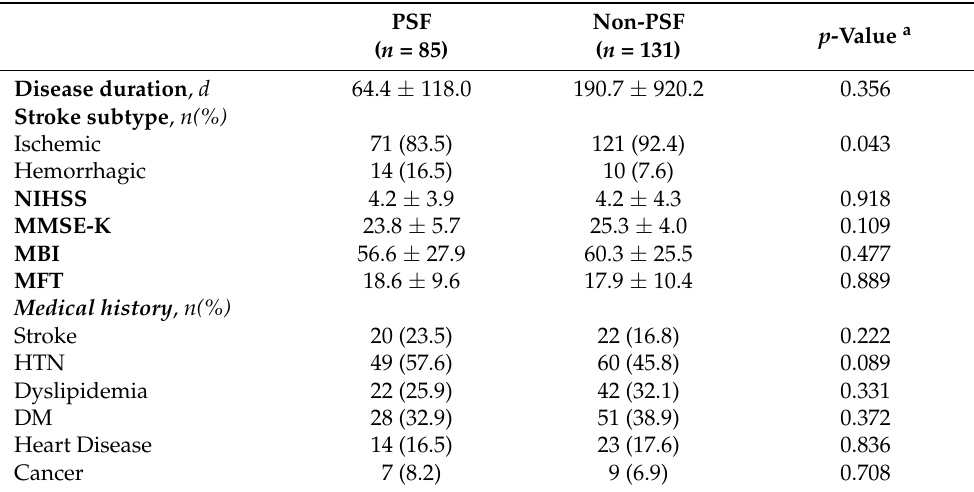
Table 2. Comparison of disease characteristics between the PSF and non-PSF groups.